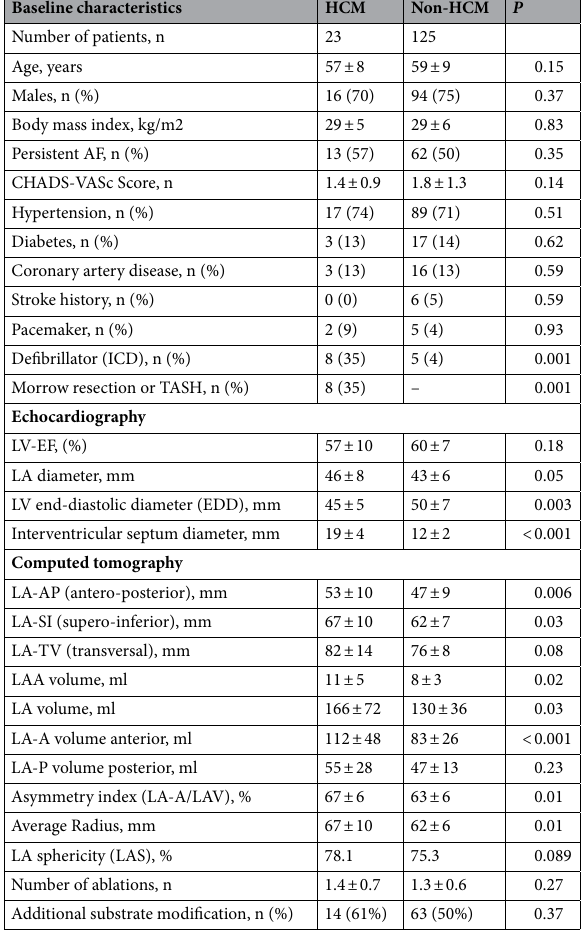
Table 1. Characteristics of patients with and without hypertrophic cardiomyopathy